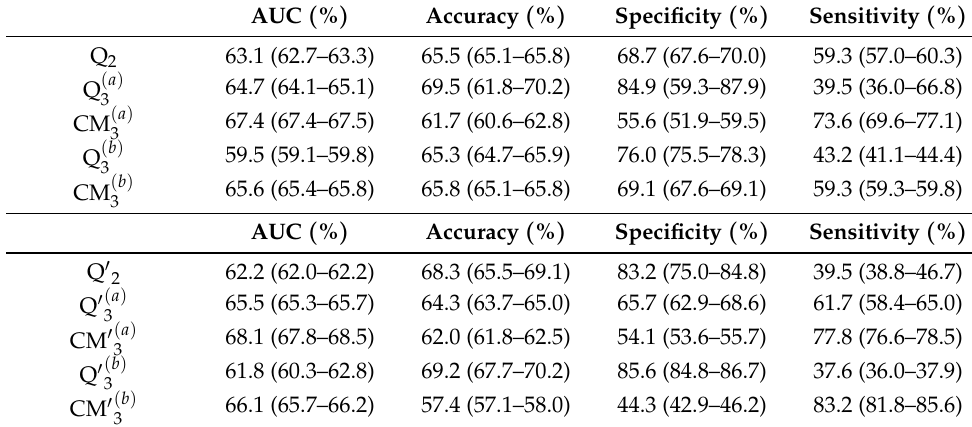
Table 3. Performances of classifiers trained over the whole dataset evaluated on 10 ten-fold cross- validation rounds and summarized in terms of the median, first, and third quartile. At the top, the quantum-inspired classifier gets percentage values for ER, PgR, and Ki67; at the bottom, their binary version is